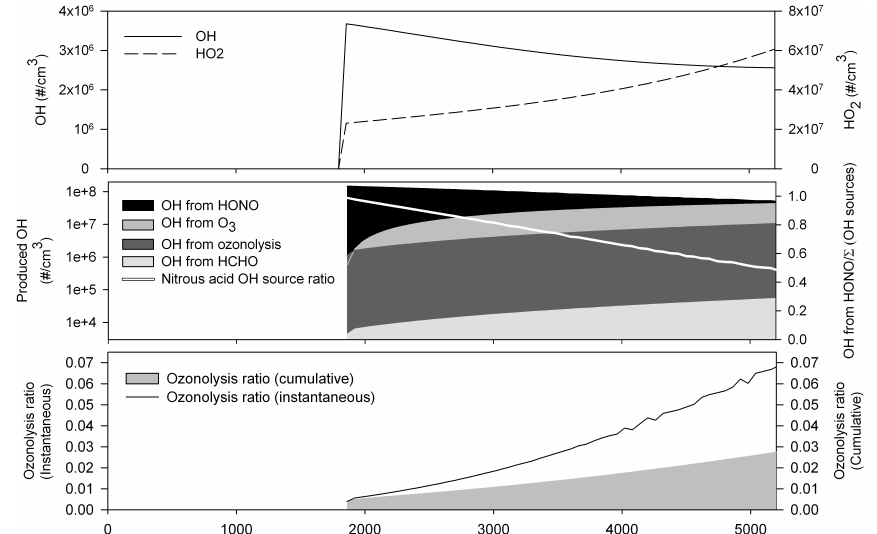
Fig. 9. Time dependent plot of the calculated HO x concentrations (top panel), the relative importance of OH sources (middle panel – areas are the instantaneous number of OH radical produced by each process while the white line is the relative importance of the HONO photolysis compared to other OH sources) and the relative importance of ozonolysis compared to OH radical initiated processes in the propene oxidation (lower panel – line is the instantaneous value while area is